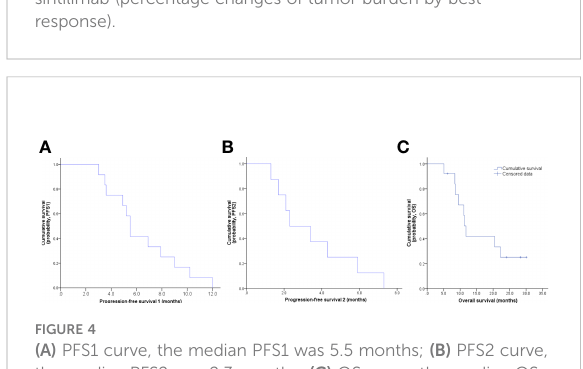
FIGURE 4 (A) PFS1 curve, the median PFS1 was 5.5 months; (B) PFS2